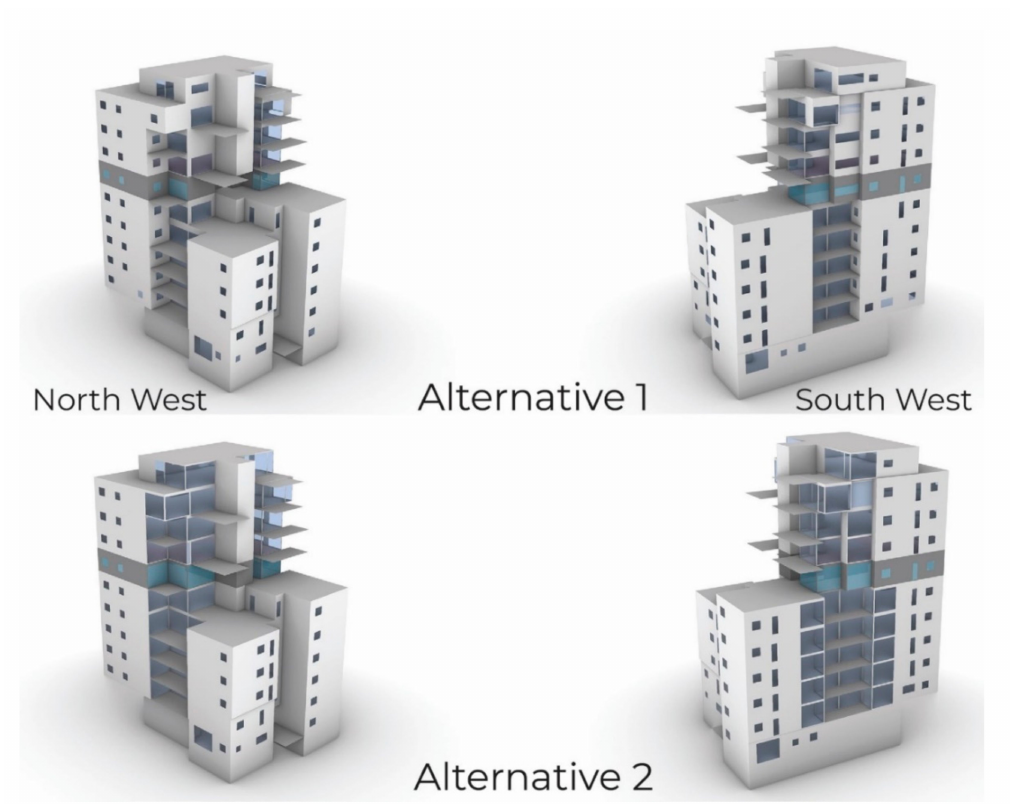
Figure 11. Case study building 2. View from northwest ( left ) and southwest ( right ). Top: Design Alternative 1; Bottom: Design Alternative 2 with larger